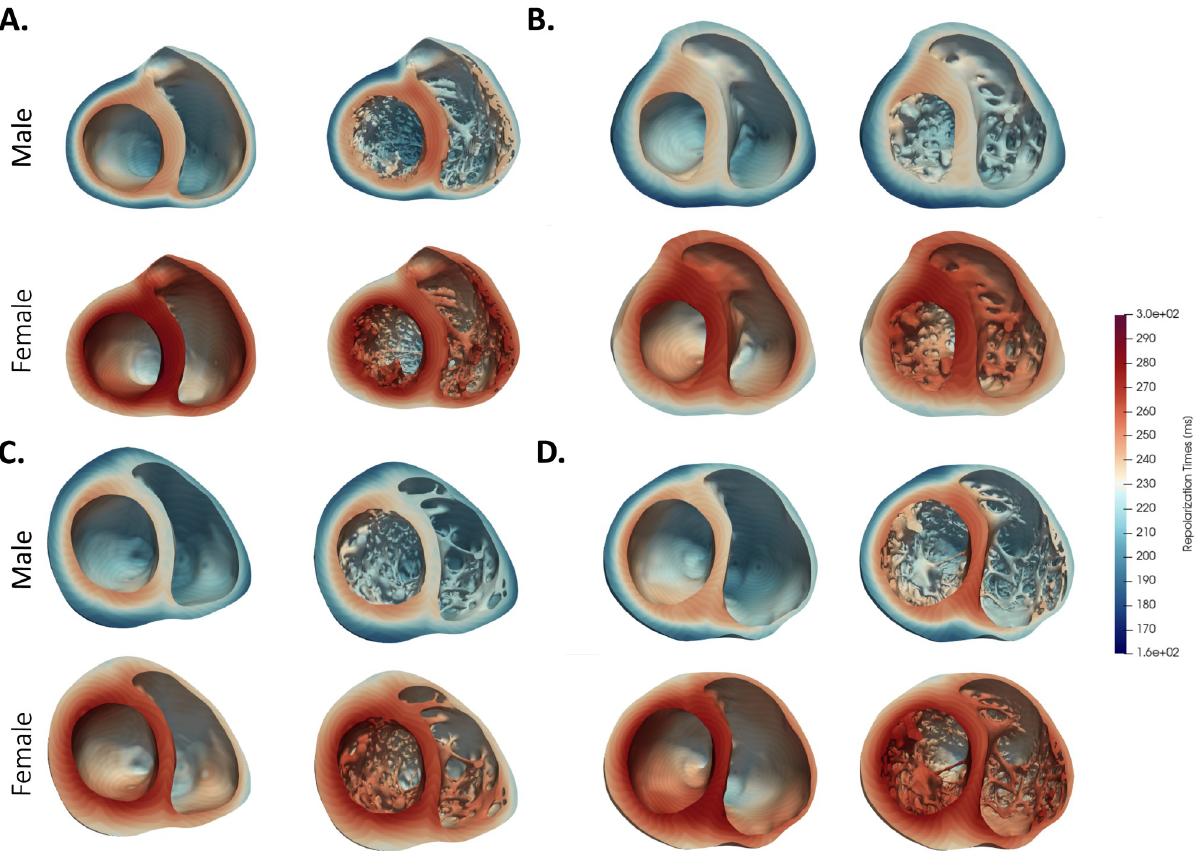
Fig 7. Repolarization map of each heart ( A-D ) for both sexes and details levels. Repolarization time is defined as the time of 90% repolarization of the